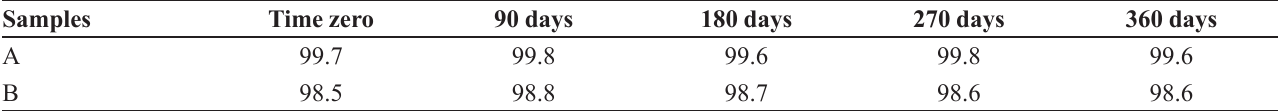
TABLE III - Assay results (%) of samples A and B at 0, 90, 180, 270 and 360 days of the stability study